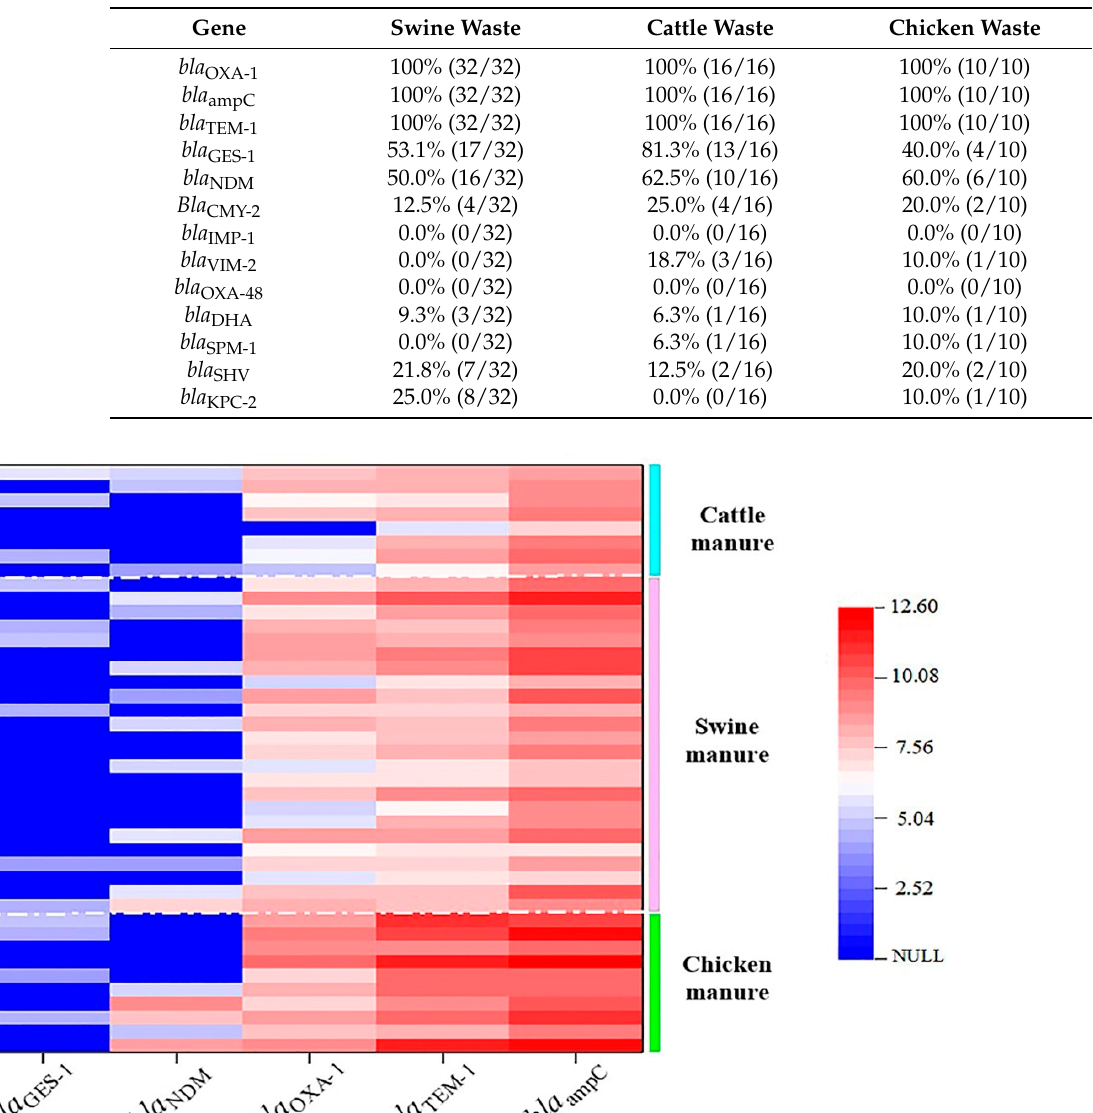
Table 2. Detection rate of bla genes in livestock waste from different family farms.